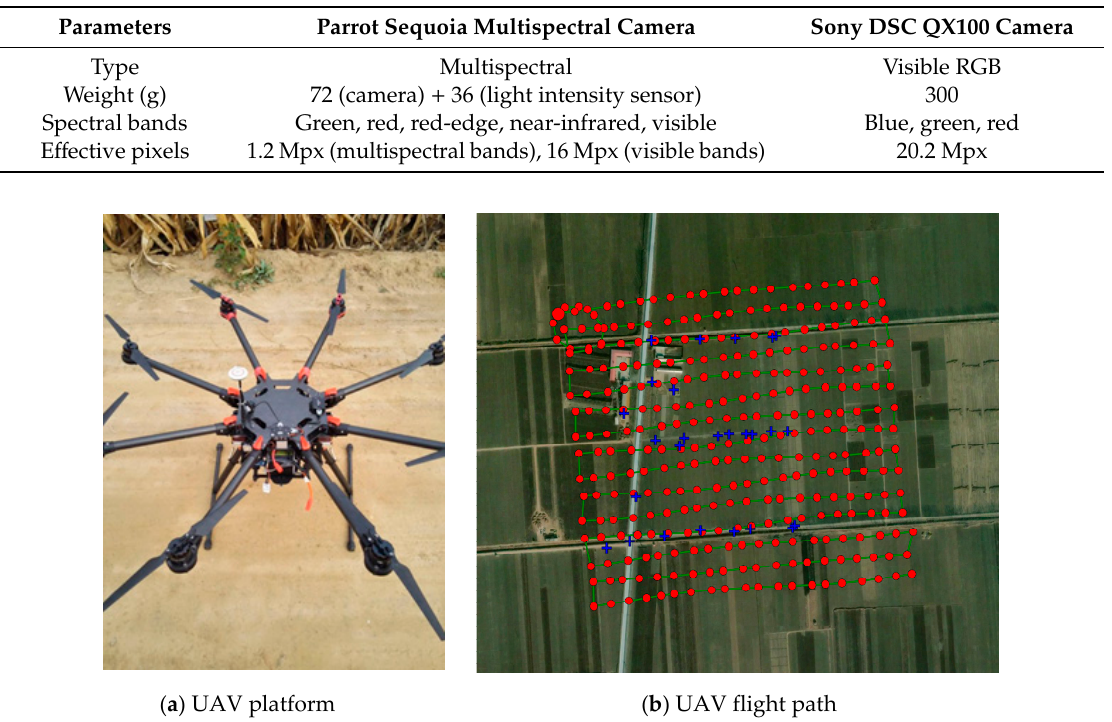
Figure 2. The DJI S1000+ UAV ( a ) used in this study and ( b ) an example of its flight path. Note: red points are the location of pictures taken by the UAV, and the blue plus signs are the locations of ground GPS.